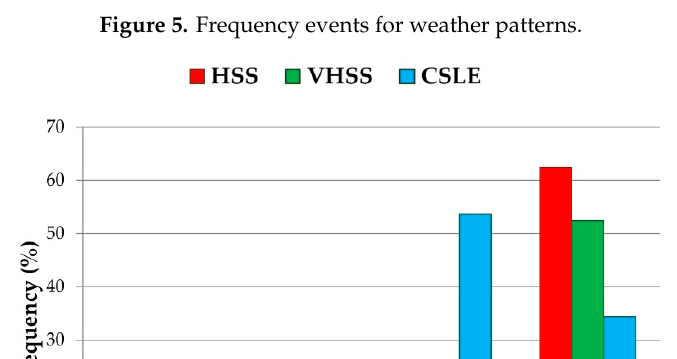
Figure 5. Frequency events for weather patterns.